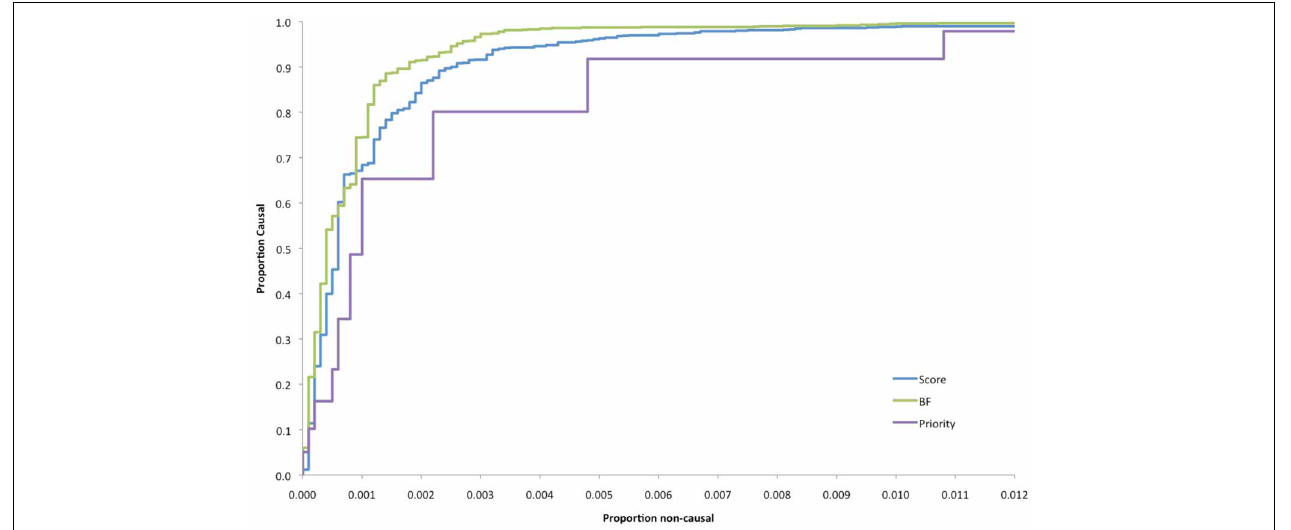
FIGURE 3 | Receiver operating curves comparing different prioritization schemes.